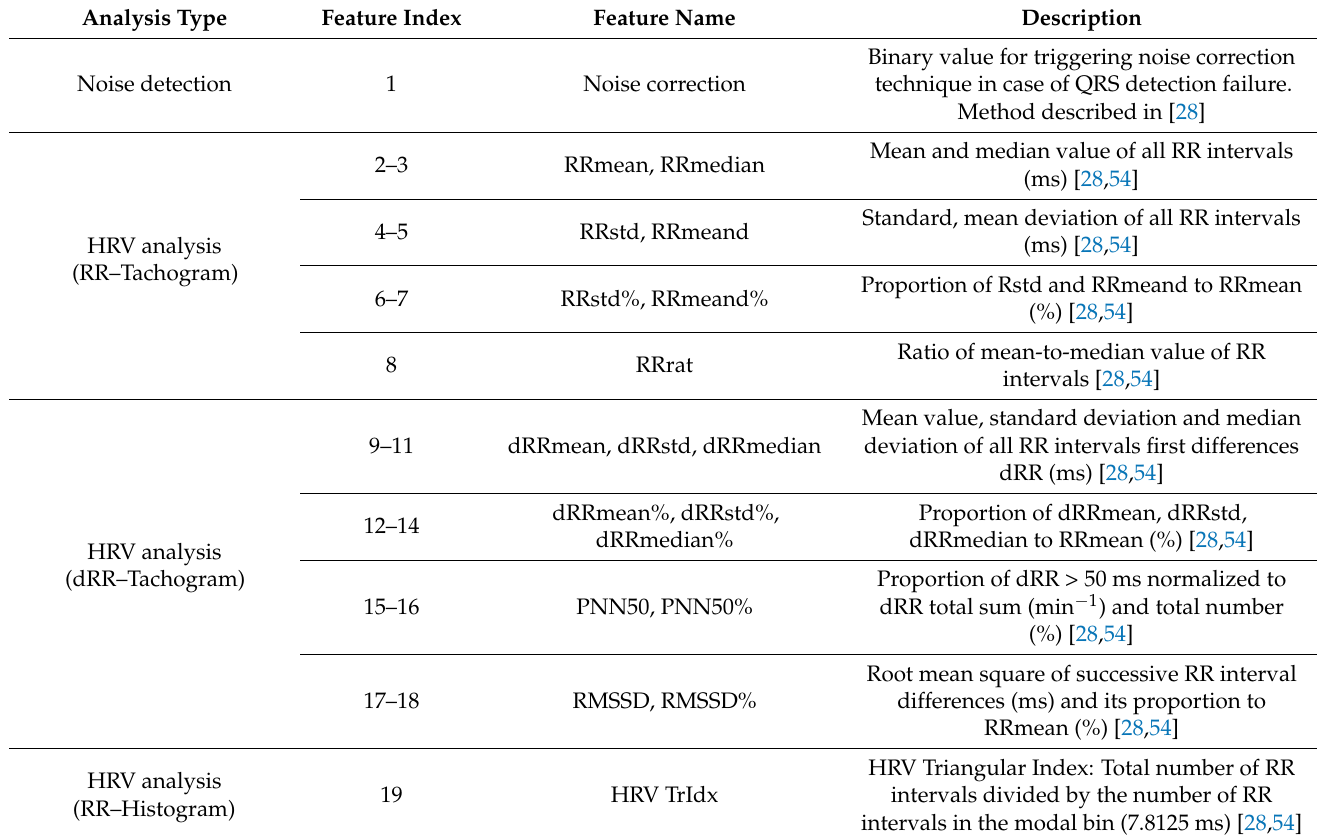
Table 2. List of computed diagnostic ECG